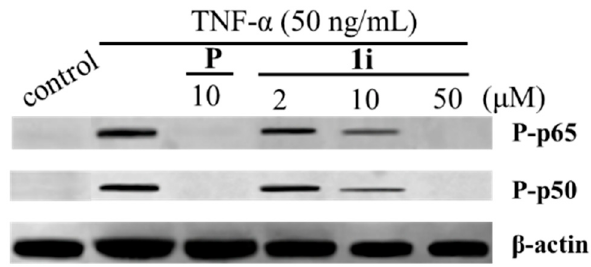
Figure 4. Compound 1 blocks TNF- α -induced NF- κ B activation through p65 and p50 phosphorylation in RAW264.7 cells. After treatment with 1 and parthenolide ( P ) at the indicated concentrations for 8 h, total cell lysates were tested by western blot experiments.